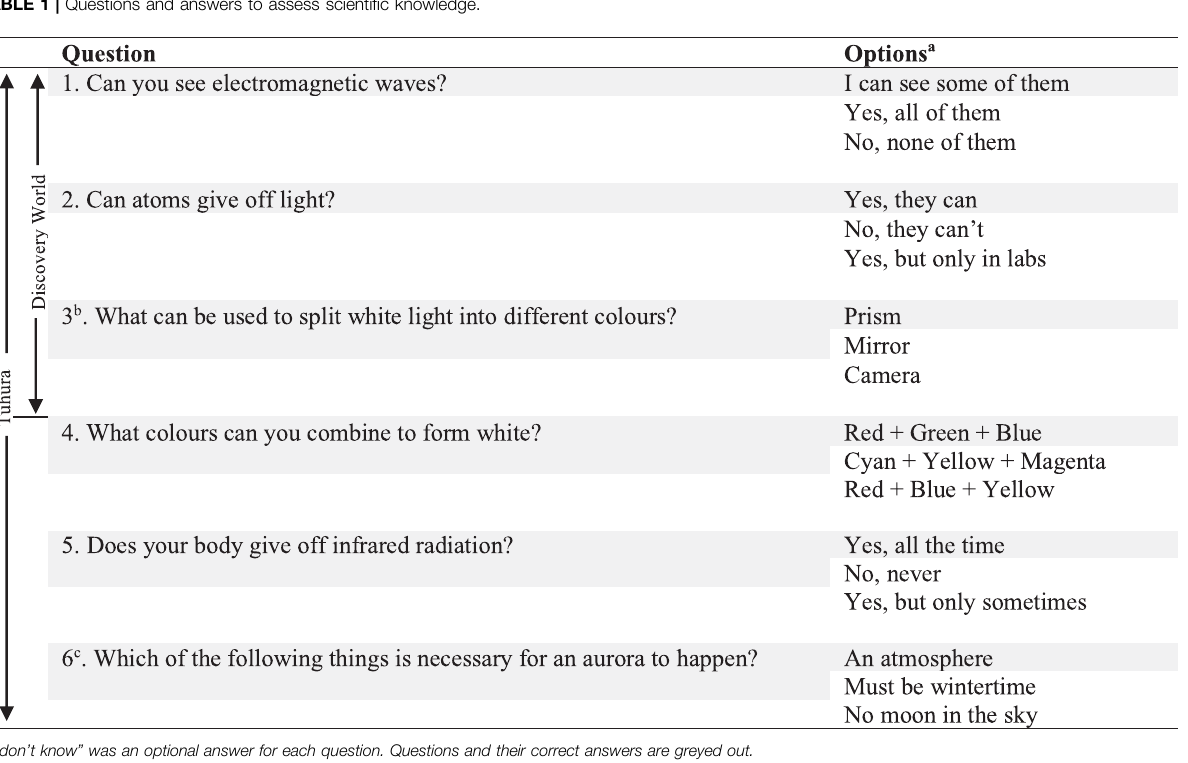
TABLE 1 | Questions and answers to assess scienti fi c